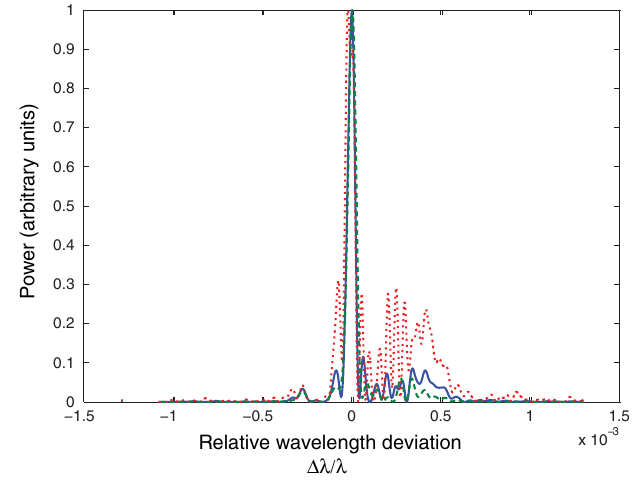
FIG. 13. (Color) Start-to-end, spectrum at saturation for the self- seeded scheme at z ¼ 20 : 5 m (green dashed line), z ¼ 22 : 5 m (blue solid line), and z ¼ 24 : 5 m (red dotted